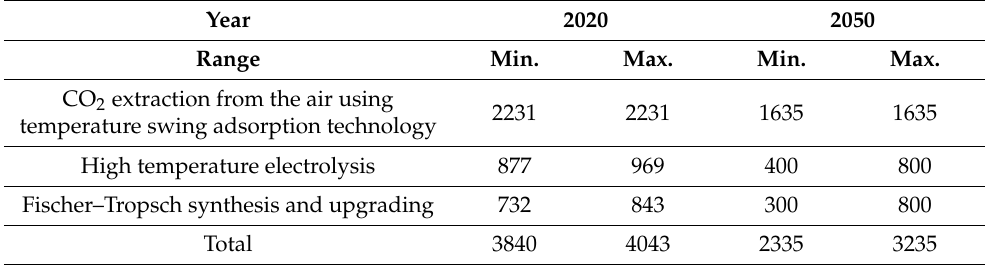
Table 2. Capital expenses (CapEx) for systems for the production of synthetic fuels in €